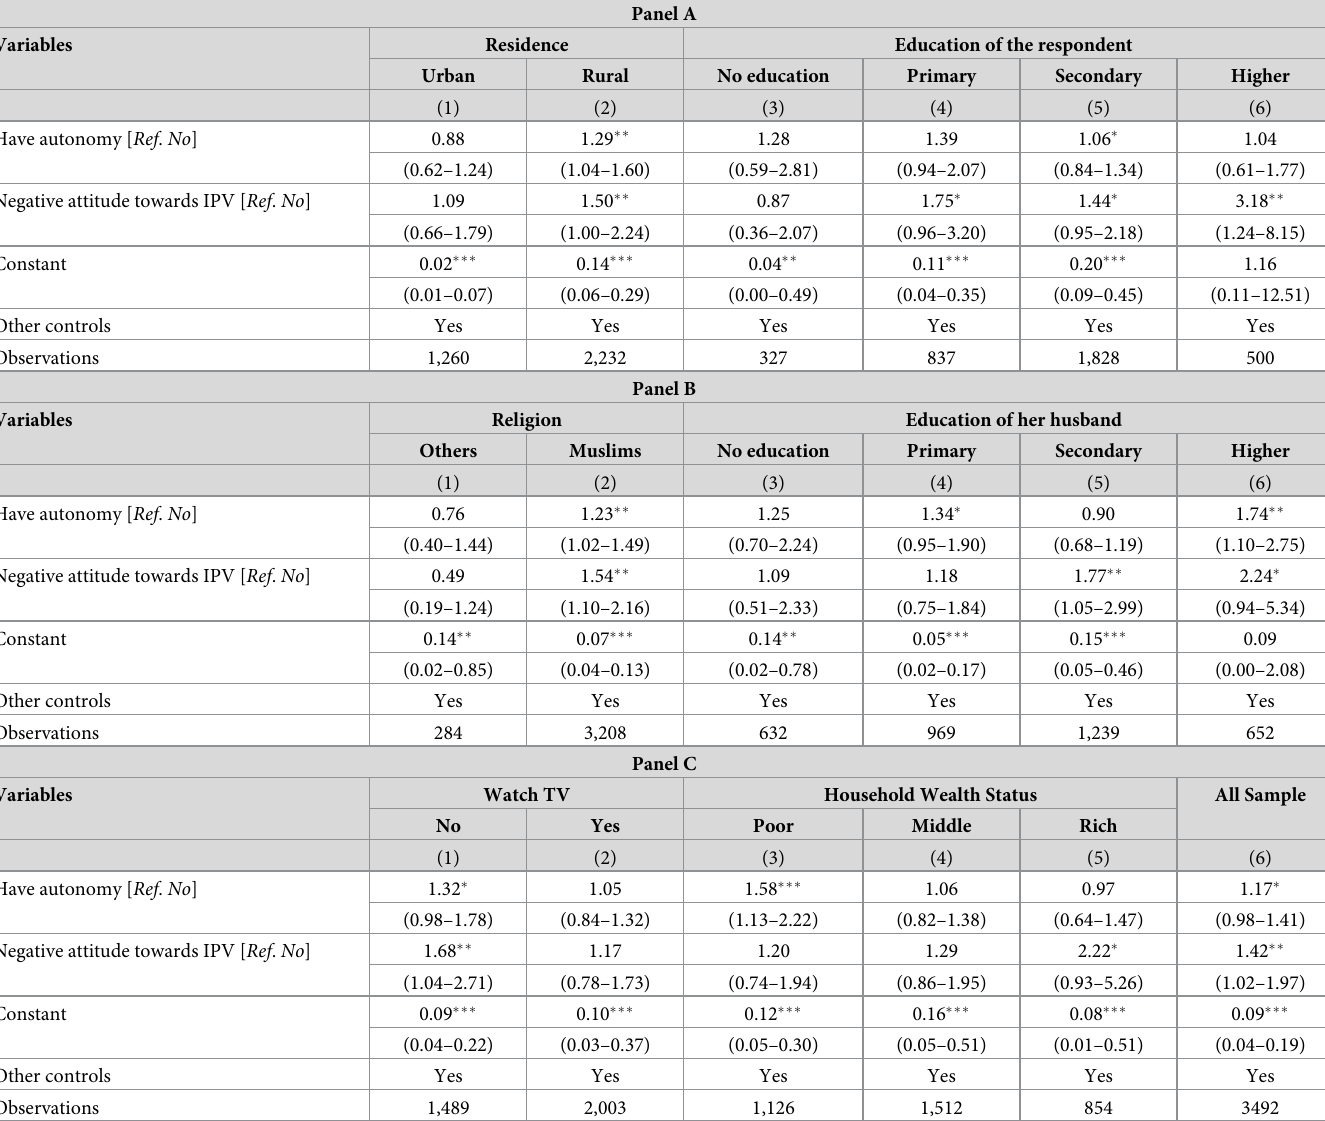
Table 4. Effect of gender inequality on access to five ANC services: Understanding the heterogeneous channels.